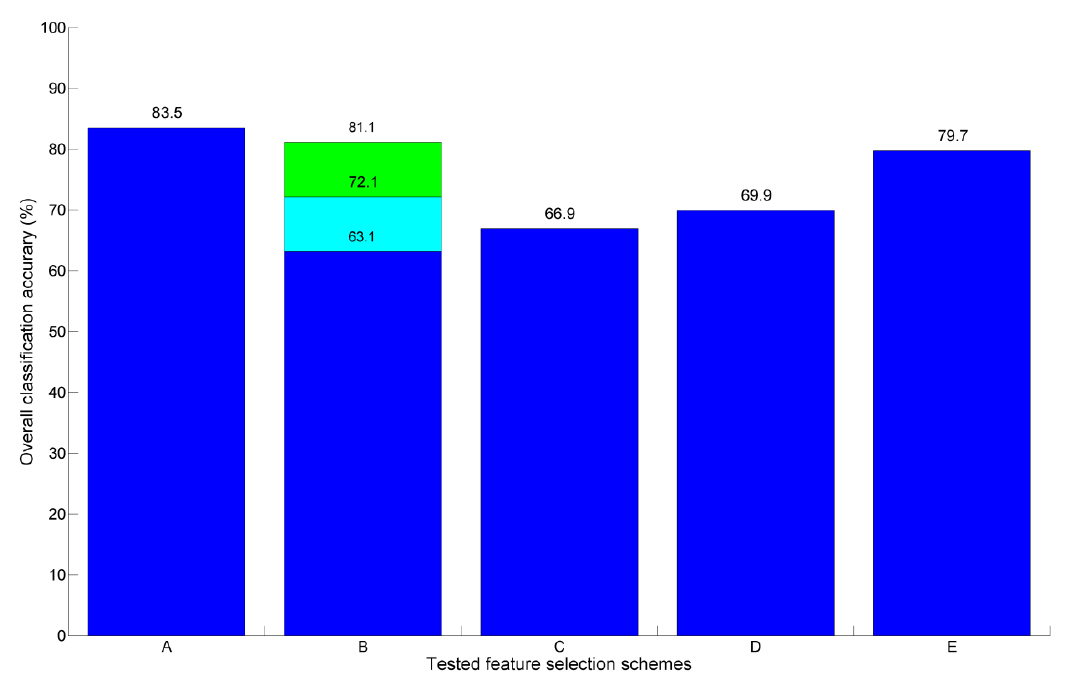
Figure 5. Classification accuracy comparison between different four-feature classification parameter sets. Bars A and B were obtained from the feature quadruples formed in Section 4.3. Bar A shows the best classification result of the feature quadruples while bar B represents their average classification result and its standard deviation (see Table